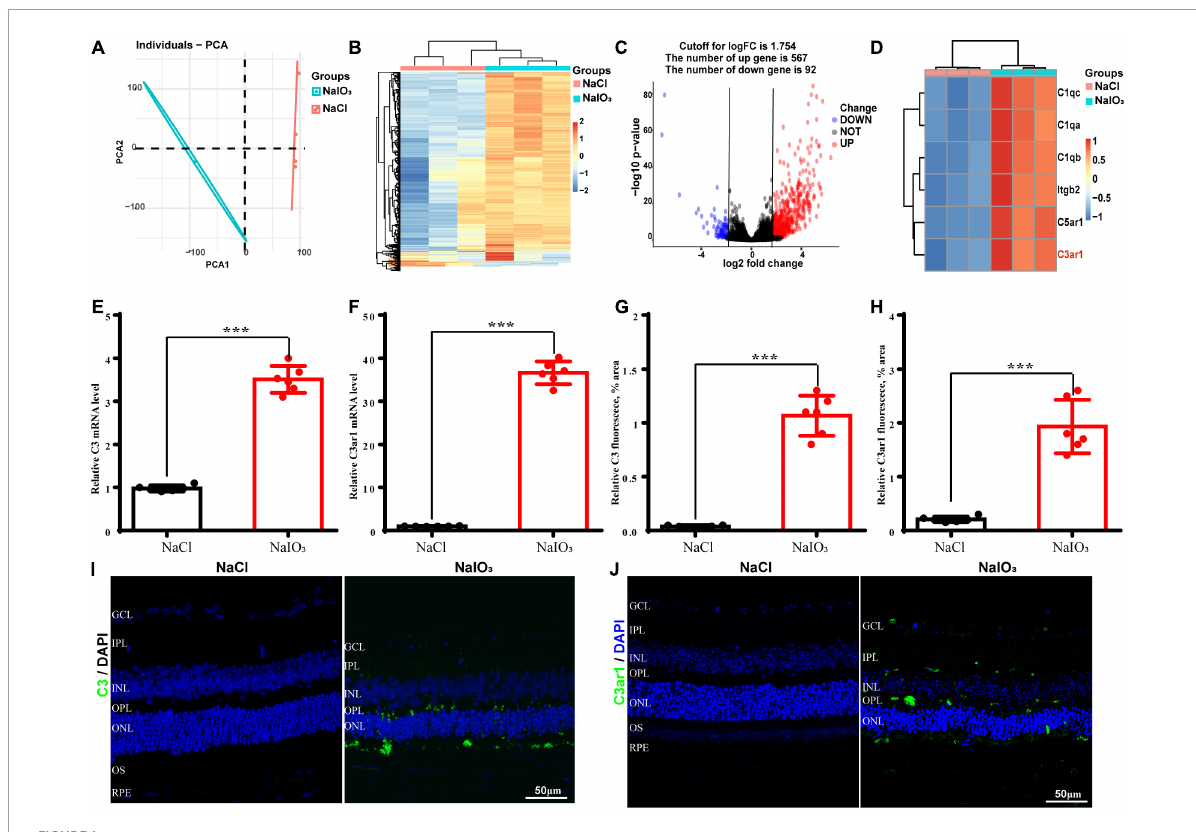
FIGURE1 Upregulation of C3 and C3aR in the NaIO 3 mouse retinal degeneration model. (A) PCA graph showing the distribution of RNA-seq samples between the control and NaIO 3 -treated groups. (B) Unsupervised clustering of the top 500 genes expressed above background levels demonstrated similar patterns of gene expression between the control and NaIO 3 -treated groups. (C) Volcano plots highlighting the distributions of DEGs between the control and NaIO 3 -treated groups. (D) Some differentially expressed complement component genes between the control and NaIO 3 - treated groups are shown as a heatmap. (E,F) The mRNA levels of C3 and C3aR in the control and NaIO 3 -treated groups were analyzed by real-time PCR. (G–J) Immunofluorescence staining and semiquantified fluorescence levels of C3 (green) and C3ar1 in saline control- and NaIO 3 -treated retinas on day 7; nuclei were counterstained with DAPI (blue) (Bars, 50 µ m). The data are expressed as the mean ± SEM *** P < 0.001, n = 6, unpaired t -test,